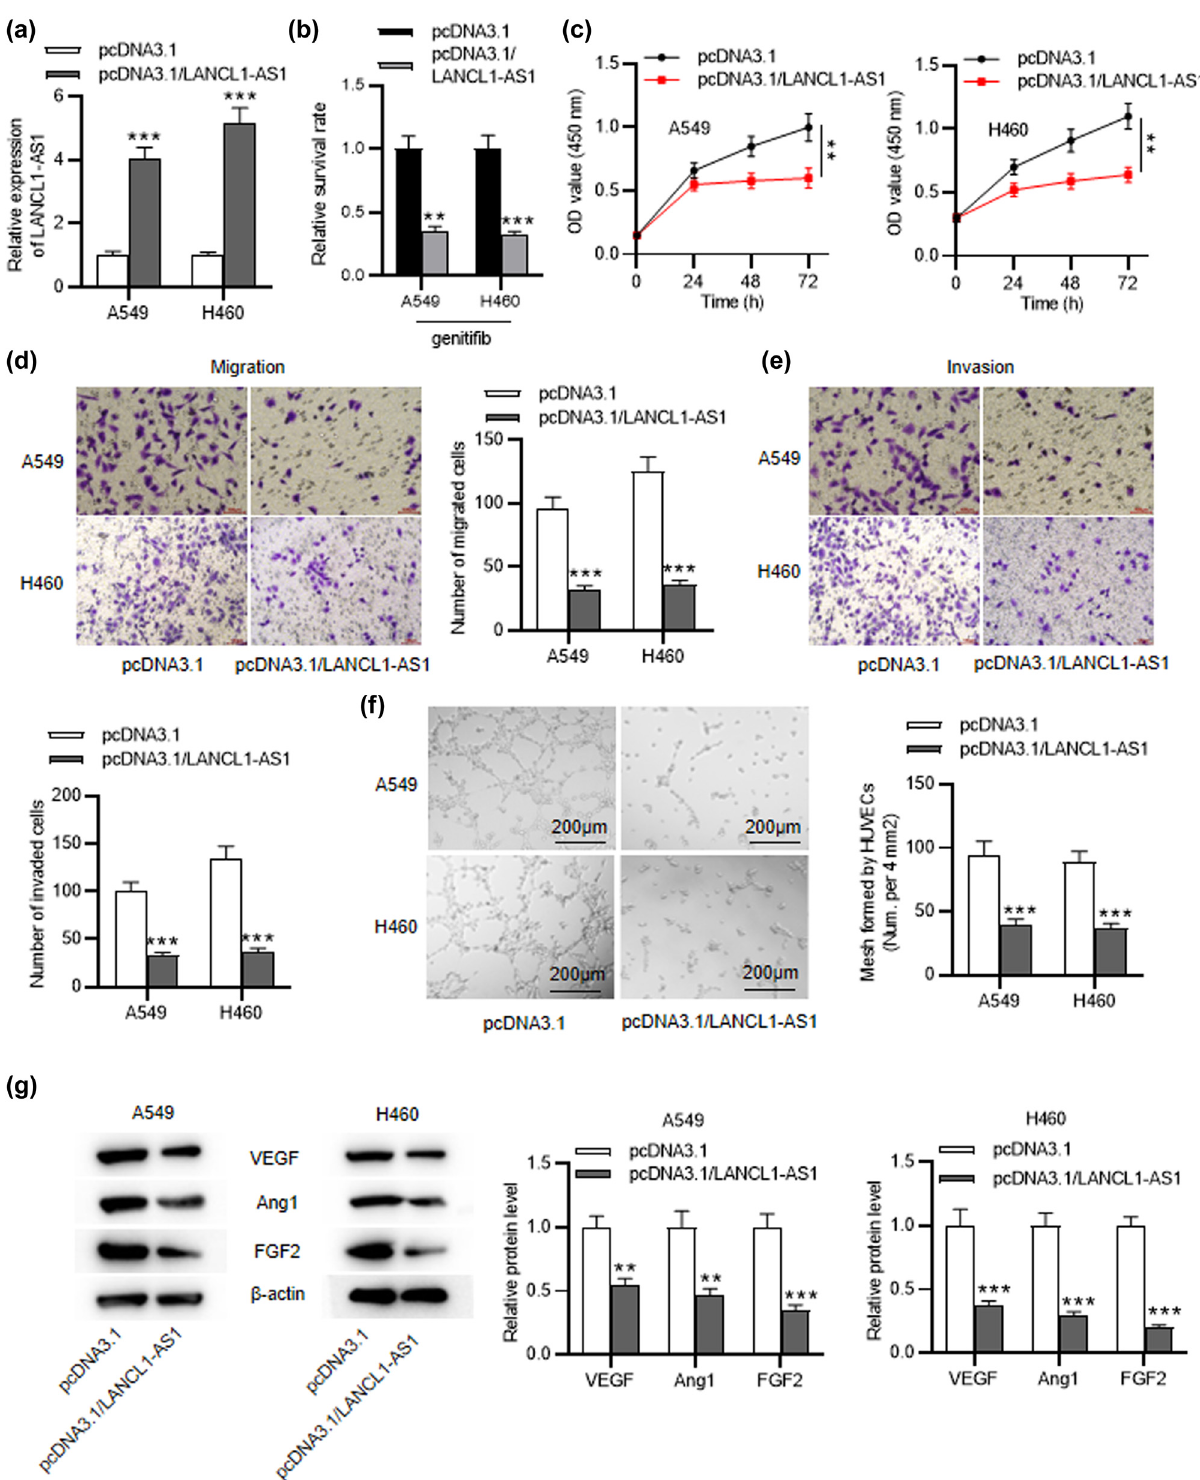
Figure 2: LANCL1 - AS1 upregulation restrains cell migration, invasiveness, and angiogenesis of NSCLC. ( a ) RT - qPCR for evaluating the transfection e ffi ciency of pcDNA3.1/LANCL1 - AS1 in A549 and H460 cells. ( b ) The survival rate of NSCLC cells with or without LANCL1 - AS1 overexpression under ge fi tinib treatment. ( c ) CCK - 8 assay for evaluating the viability of LANCL1 - AS1 - overexpressed A549 and H460 cells. ( d and e ) Transwell assays for evaluating cell migratory and invasive capabilities after LANCL1 - AS1 overexpression. ( f ) Tube formation assay for assessing angiogenic ability of HUVECs with LANCL1 - AS1 upregulation. ( g ) Western blotting for evaluating levels of angiogenesis - related proteins. ** p < 0.01, *** p <